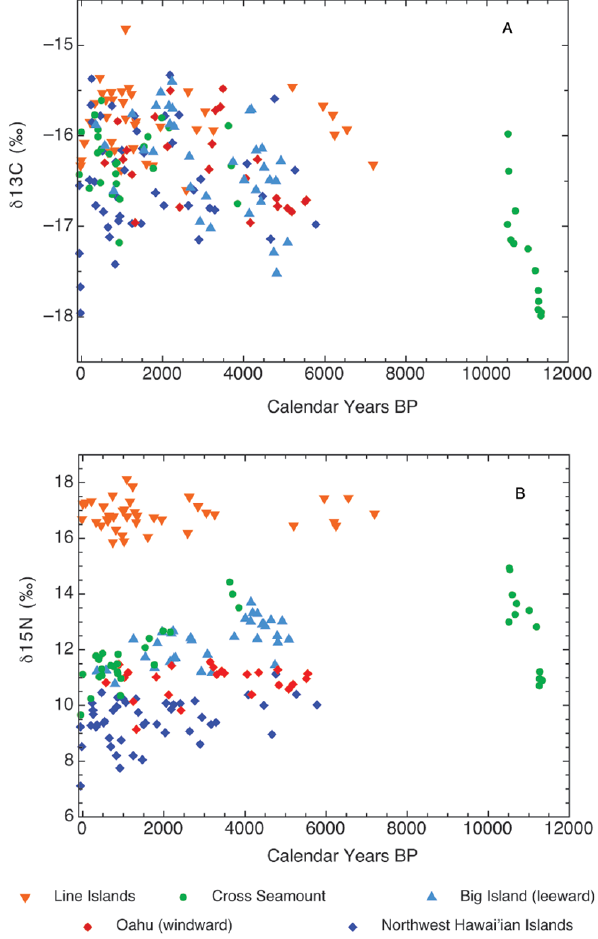
Fig. 4. (A) Upper panel: bulk Gerardia δ 13 C (‰ VPDB); and (B) lower panel: δ 15 N (‰ air) as a function of time and location. Each sample represents approximately